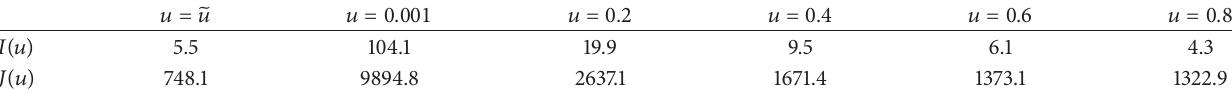
Table 1: The values of 𝐼 and objective function 𝐽 under different control strategies 𝑢 .